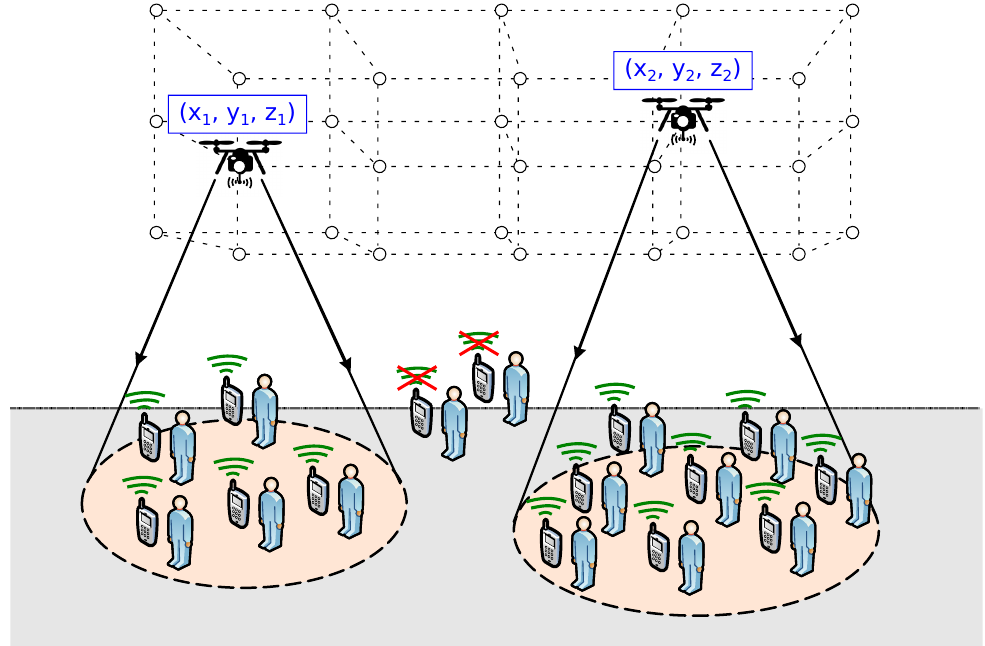
Figure 3. UAVs placement